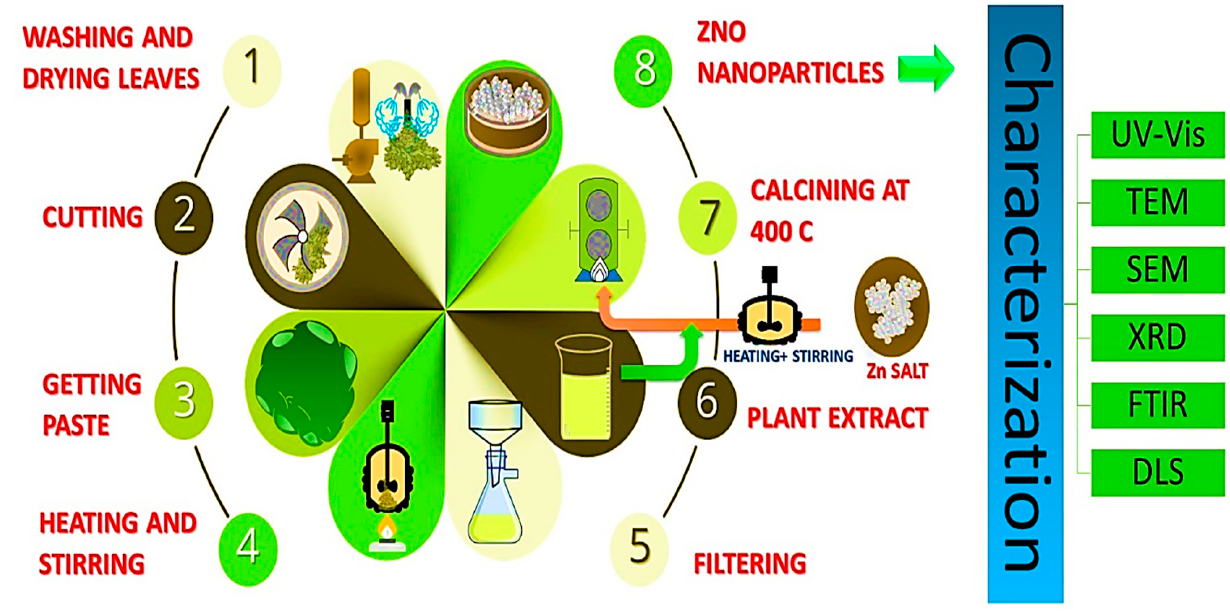
Figure 4. Key steps of the green synthesis of zinc oxide nanoparticles.